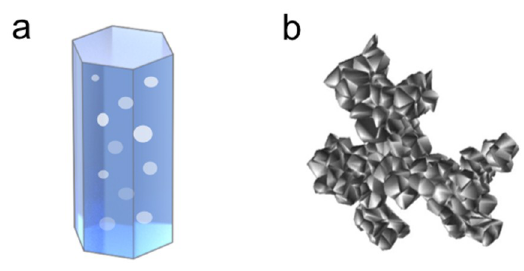
Figure 20. ( a ) Inhomogeneous ice particle containing randomly located air bubbles; and ( b ) Voronoi particle shape (courtesy of Hiroshi Ishimato).